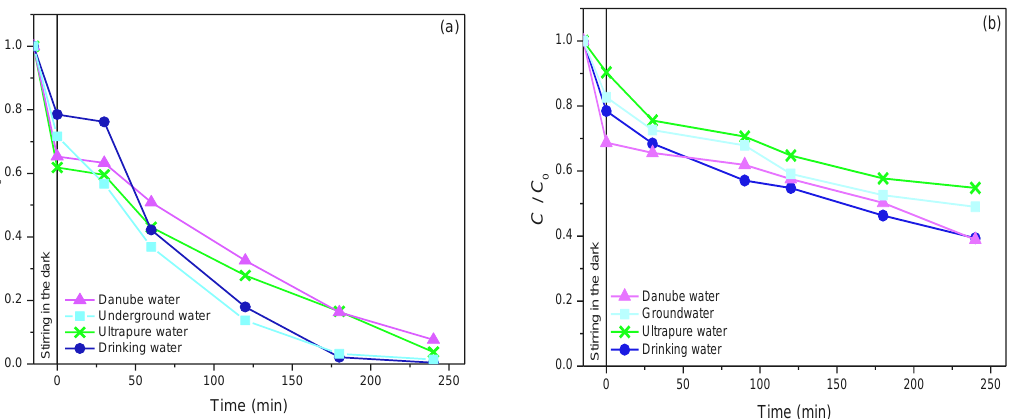
Figure 10. Influence of water matrix on the removal of sulcotrione ( a ) and amitriptyline ( b ) under the following experimental conditions: substrate (0.05 mmol/dm 3 ) in the presence of 19ZrO 2 /Fe 3 O 4 (1.0 mg/cm 3 ) nanopowders with H 2 O 2 (3.0 mmol/dm 3 ) at pH 2.8, using solar irradiation.